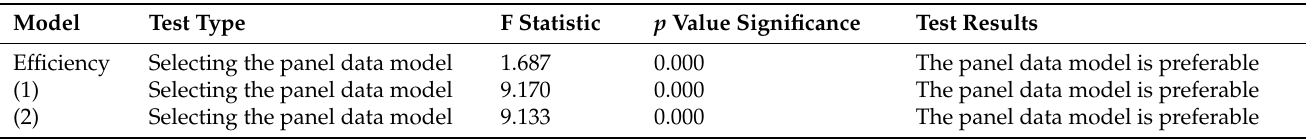
Table 5. Chow test